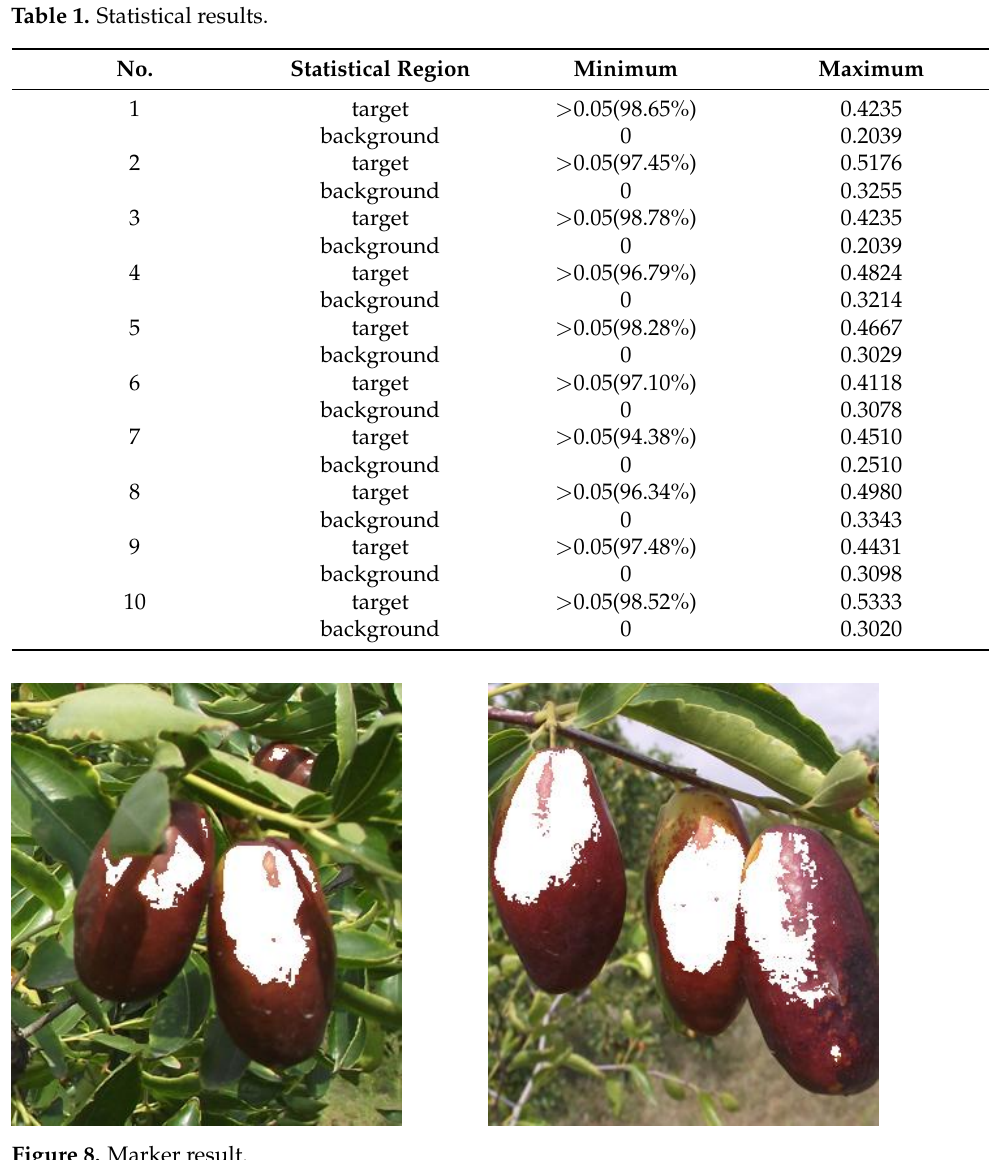
Figure 8. Marker